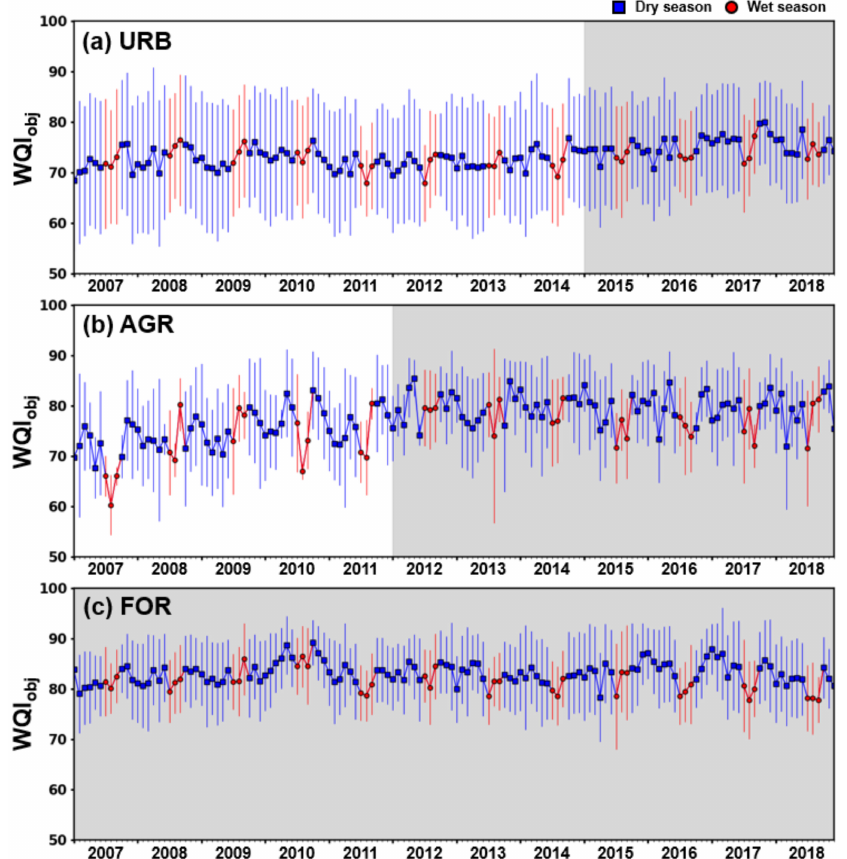
Figure 3. Long-term (2007–2018) trends of objective water quality index (WQI obj ) for watersheds with ( a ) urban-dominated, ( b ) agriculture-dominated, and ( c ) forest-dominated land-cover. Blue and red circles denote the mean monthly WQI obj for dry and wet seasons, respectively, and vertical lines denote one standard deviation of monthly WQI obj . The gray area represents a period exhibiting no significant increase or decrease in WQI obj based on the results of seasonal Mann-Kendall